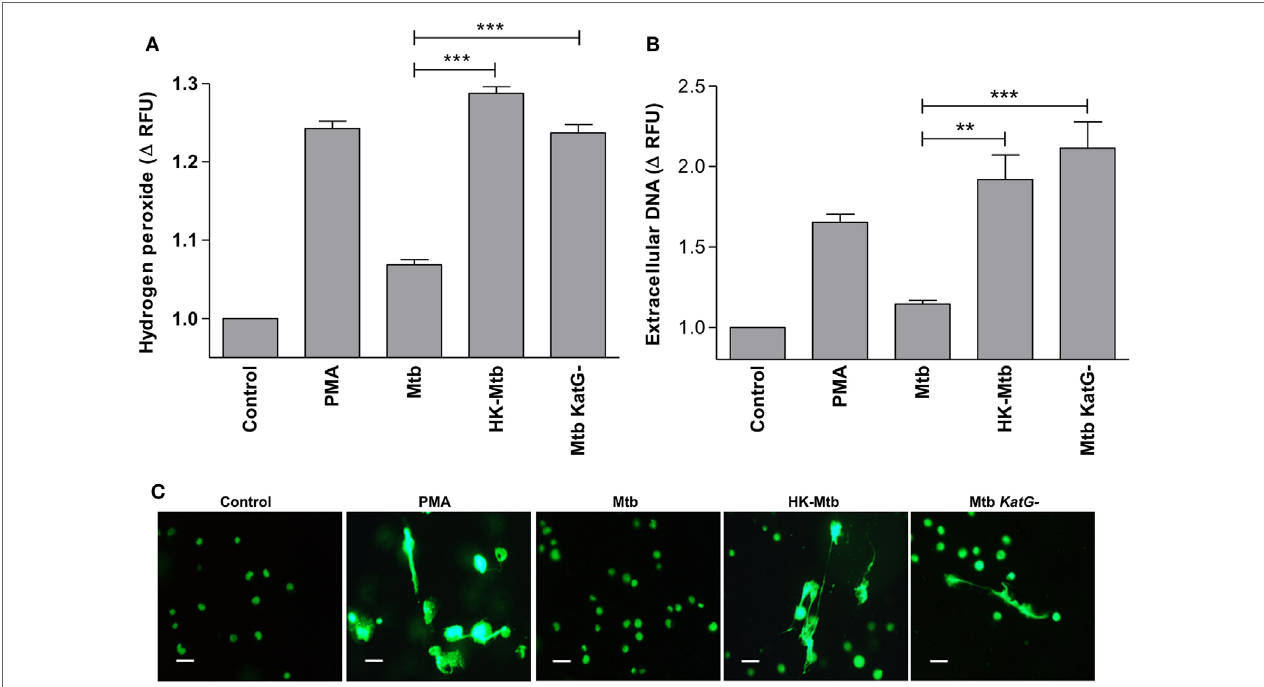
FigUre 6 | Catalase deficient Mycobacterium tuberculosis (Mtb KatG-) induce release of MCETs. (a) HMC-1 cells were left unstimulated (Control) or stimulated with PMA, live Mtb, heat-killed Mtb (HK-Mtb), or with a Mtb katG -deleted strain (Mtb KatG − ) for 90 min and H 2 O 2 was evaluated. The graph represents the change in fluorescence ± SD of stimulated cells compared to unstimulated cells *** p < 0.001 as indicated. (B) Extracellular DNA was evaluated in HMC-1 mast cells after 2 h of stimulation with PMA, live Mtb, HK-Mtb, or Mtb katG − . The graph represents the change in fluorescence ± SD of stimulated cells compared to the